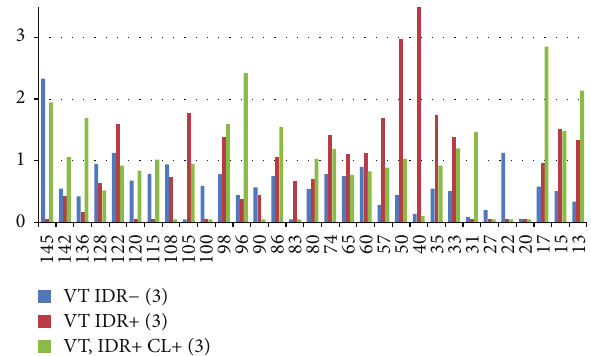
Figure5:IODareavaluesinVTvaccinatedvolunteersafterprimary infection in intradermic reaction (IDR) negative, IDR positive, and IDR+ with diagnosis of cutaneous leishmaniasis (CL) (patients). Standard deviations were 5–20% of average and are not shown